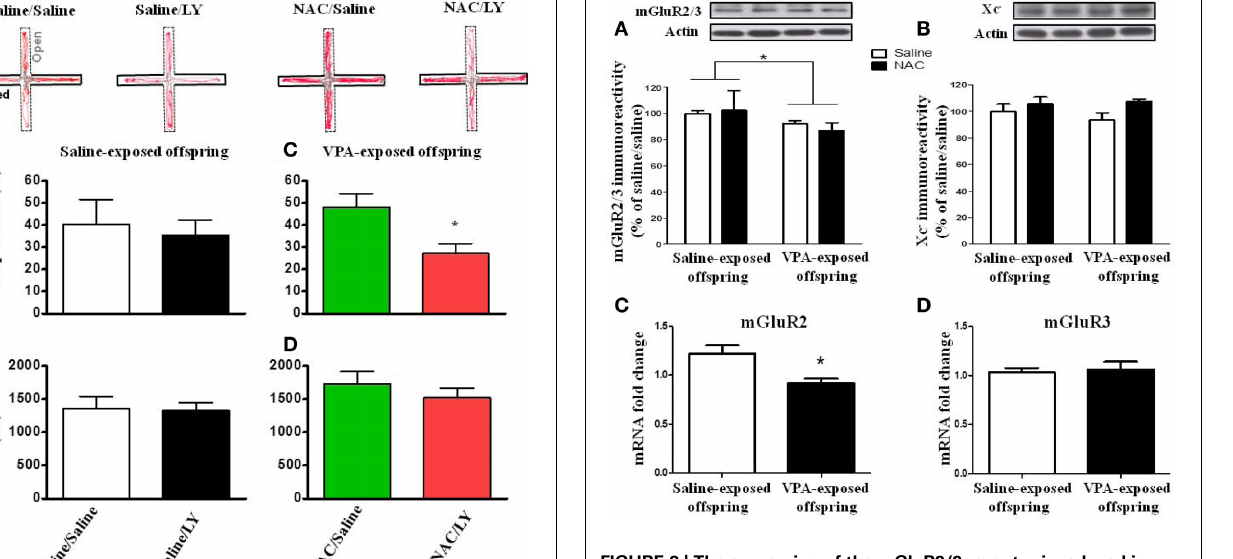
FIGURE 8 | The expression of the mGluR2/3 receptor is reduced in VPA-exposed offspring. (A,B) Rats of saline- or VPA-exposed offspring weaned at postnatal day 21 were administered NAC (150mg/kg, i.p.) or saline once per day for 7 days. Twenty-four hours after the last injection of NAC, the amygdala mGluR2/3 (A) and Xc − (B) protein levels were determined by Western blotting analysis. ∗ p < 0 . 05. (C,D) The mRNA levels of mGluR2 and mGluR3 were determined by RT-PCR